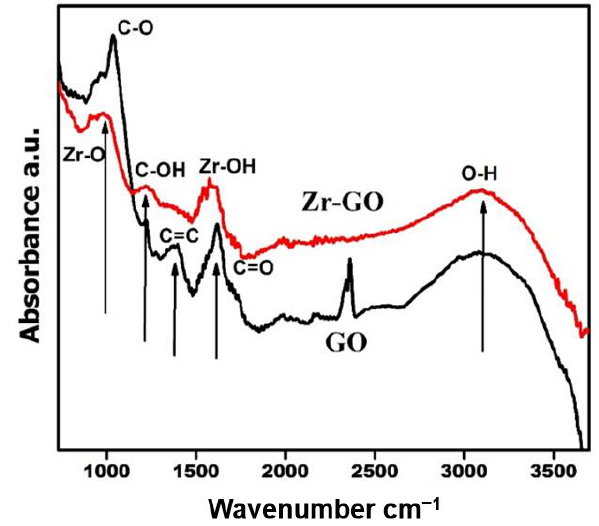
Figure 2. FTIR spectrum of GO and Zr-GO.